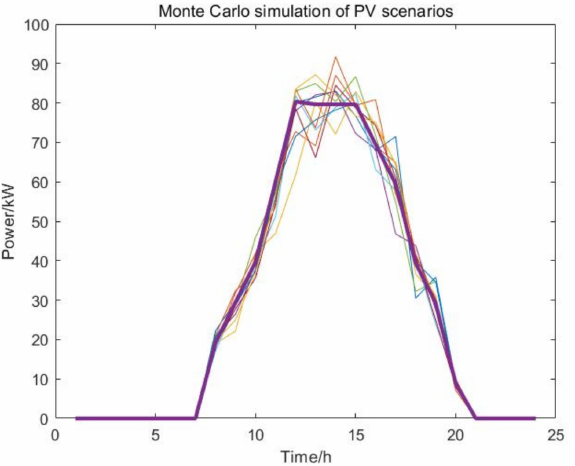
Figure A2. Typical PV power scenarios.